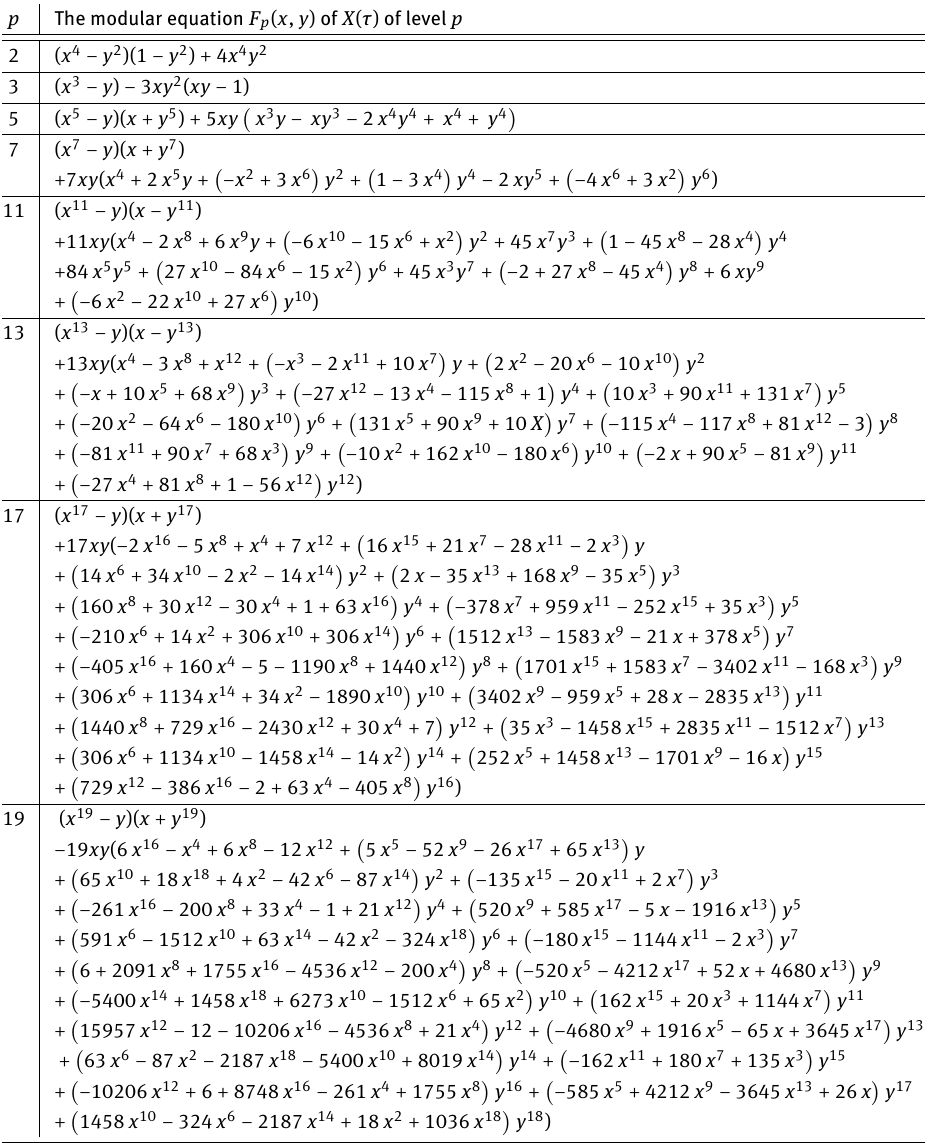
p The modular equation F p ( x , y ) of X ( τ ) of level